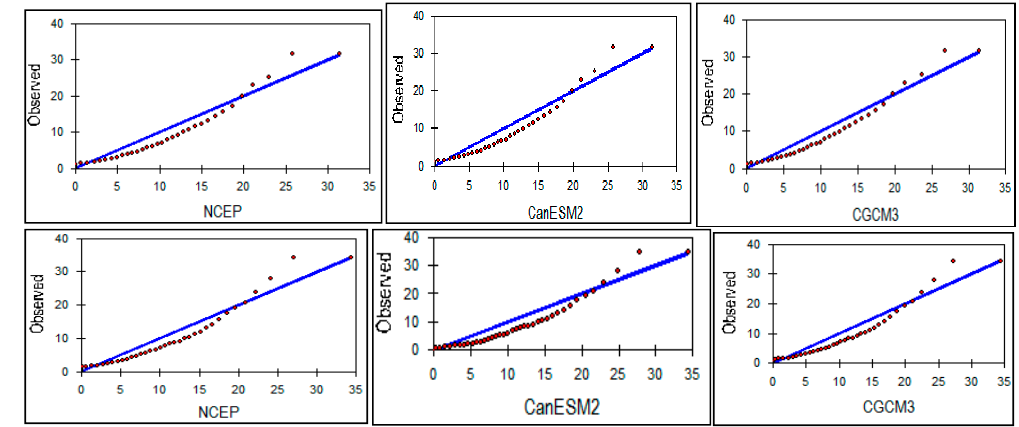
Figure 5. Observed and modeled precipitation at Addis Ababa (upper) and Entoto (bottom) stations during the validation period.